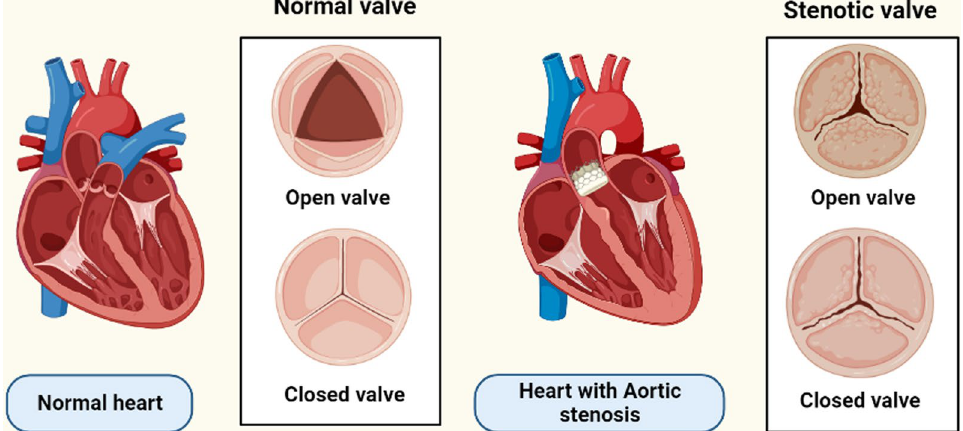
Fig. 1 Diagrammatic representation of normal aortic valve versus aortic